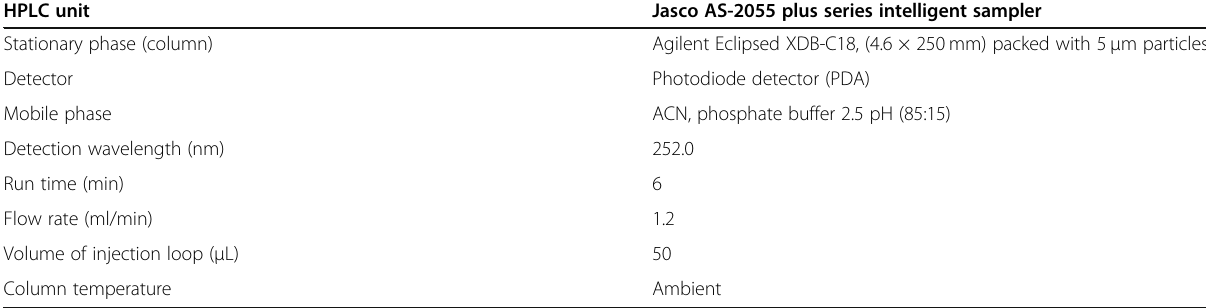
Table 1 Optimized chromatographic condition